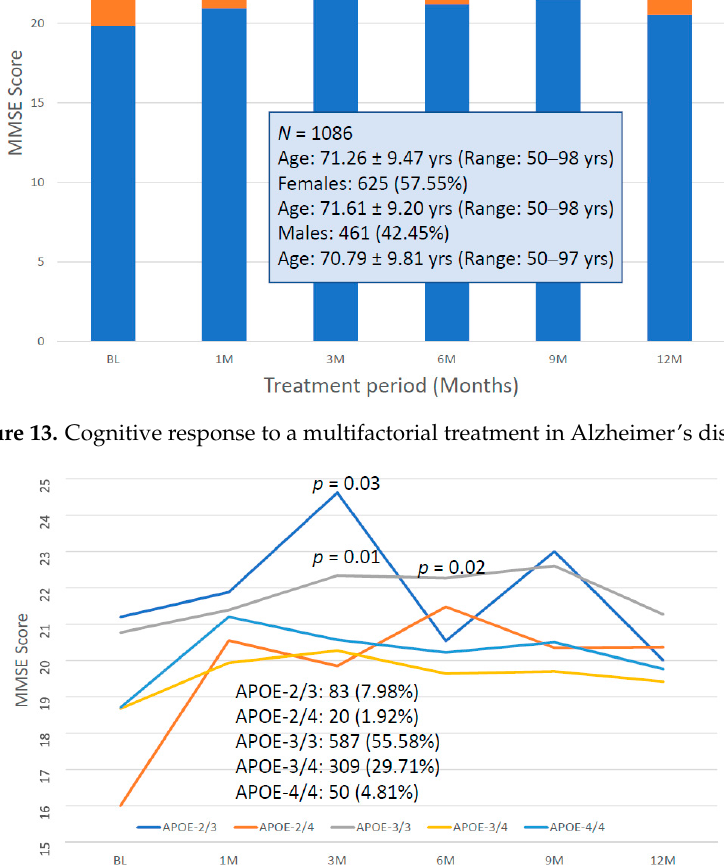
Figure 14. APOE -related therapeutic response to a multifactorial treatment in Alzheimer’s disease.